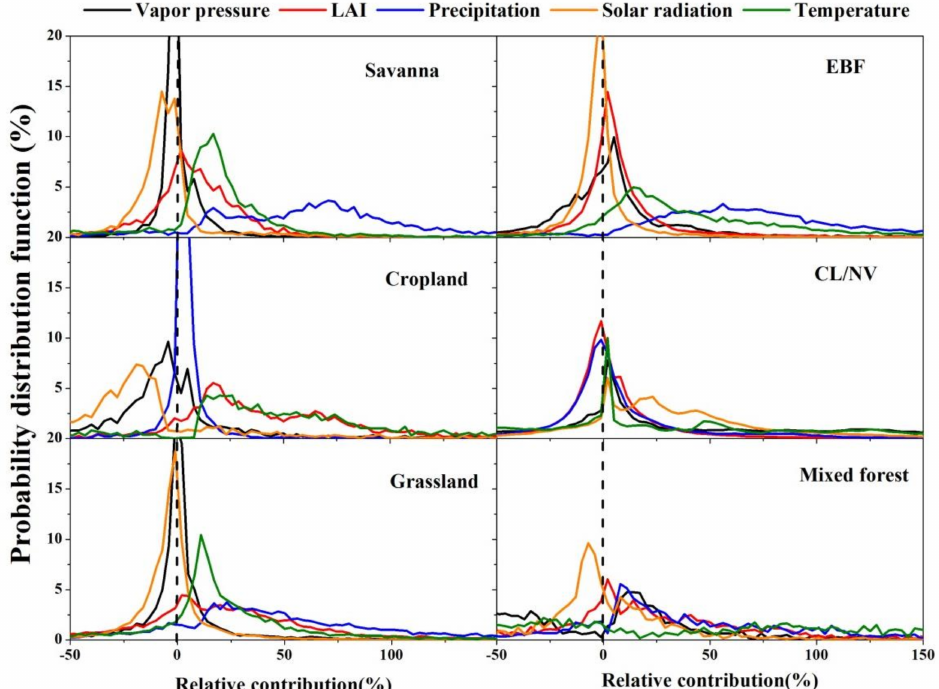
Figure 9. Probability distribution function of relative contributions of climatic variables and LAI changes to ET a trends in different vegetation